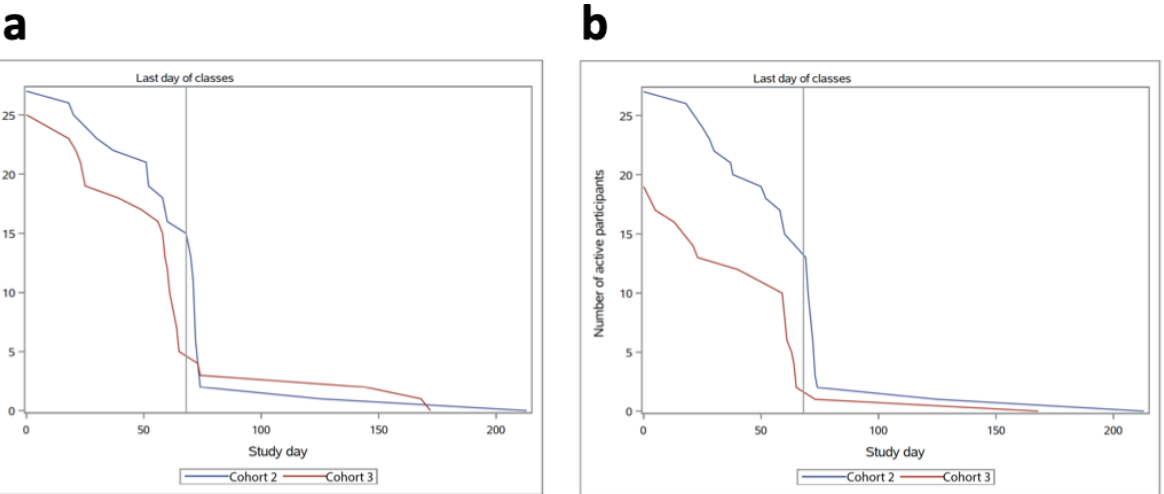
Figure 7. The number of active participants recording diary entries over the course of the study (a) active participants providing activity diary entries and (b) active participants providing diary entries of fruit and vegetables. The study day of drop-off was determined by the latest date of data entry for each module.